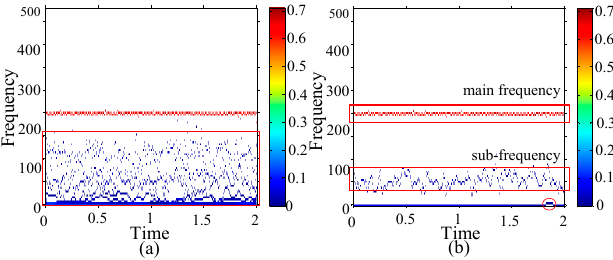
Figure 17. Holes of 0.5 mm on both inner and outer race ( a ) HHT spectrum ( b ) GEMD-HHT spectrum.